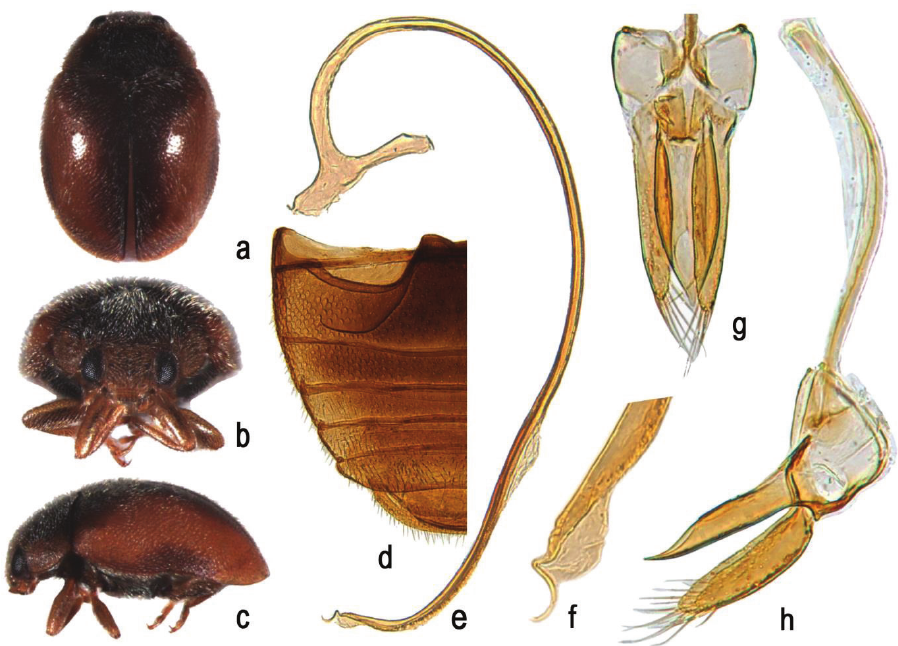
Figure 3. Scymnus ( Scymnus ) nubilus Mulsant: a dorsal view b anterior view c lateral view d abdomen e penis f apex of penis g tegmen, ventral view h tegmen, lateral Scymnus ( Scymnus ) nubilus Mulsant, 1850 Fig. 3 Scymnus nubilus Mulsant, 1850: 972; Bielawski 1972: 293; Booth and Pope 1989: 359; Canepari 2001: 207; Chen et al. 2013: 438. Scymnus ( Scymnus ) nubilus : Korschefsky 1931: 143; Kapur 1972: 311; Miyatake 1985: 9; Yu and Pang 1992: 44; Poorani 2002: 358; Kovář 2007: 590; Yu 2011: 131; Chen et al. 2013: 438.